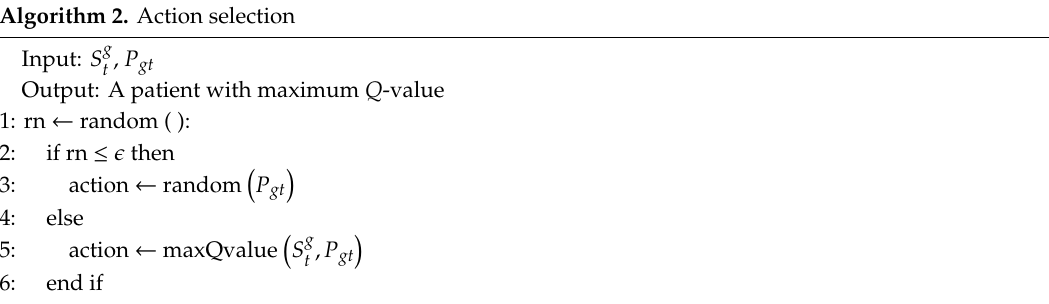
Algorithm 2. Action